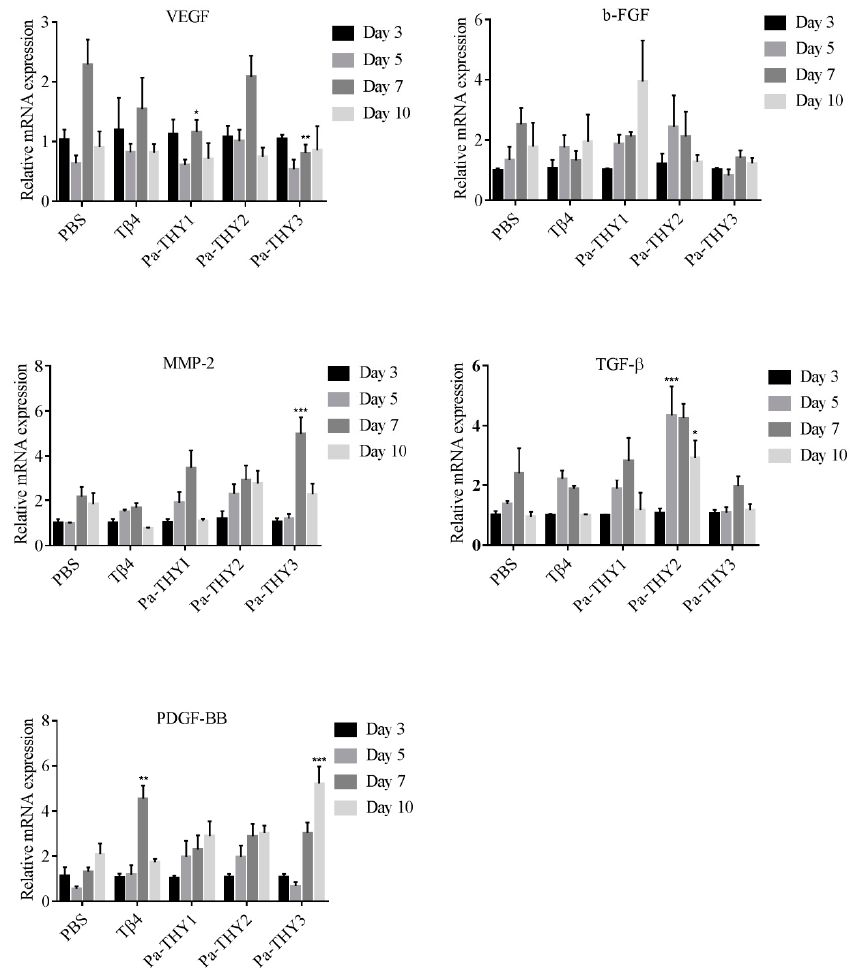
Figure 9. The expressions of vascular endothelial growth factor (VEGF), fibroblast growth factor (b-FGF), transforming growth factor- β (TGF- β ), matrix metallopeptidase 2 (MMP-2), and platelet derived growth factor-BB (PDGF-BB) in mice treated with T β 4 and Pa-THYs proteins were determined by qRT-PCR. All the factors were compared to PBS group in certain time point, Two-way ANOVA analysis, * p < 0.05; ** p < 0.01; *** p < 0.001.